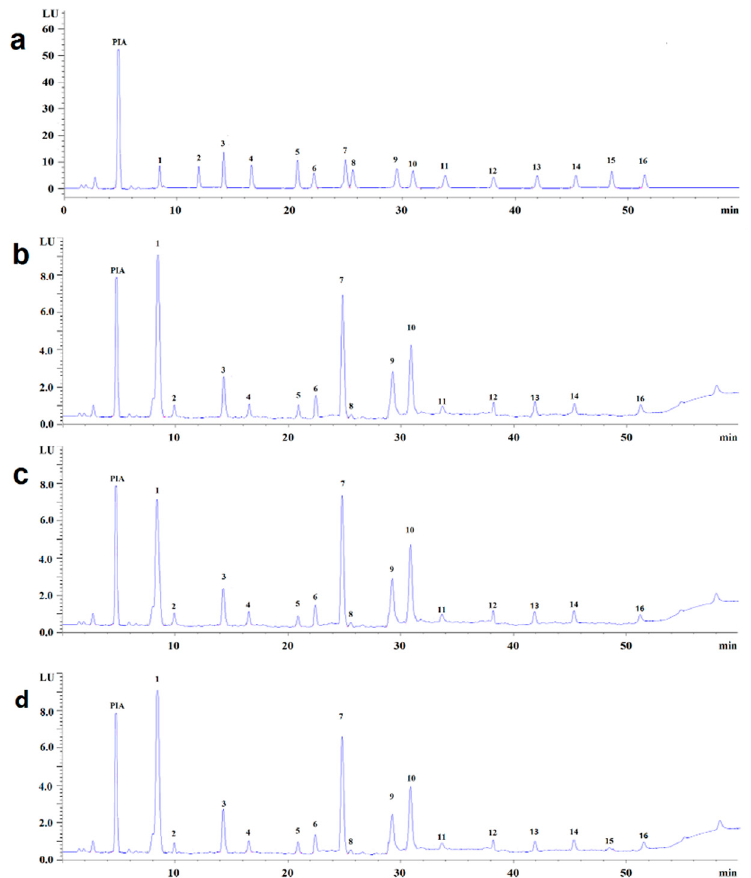
Figure 2. The representative chromatograms for standards ( a ), the typical chromatograms for fatty acid extracts in Potentilla anserina L from Gannan Tibetan Autonomous Prefecture by SFE ( b ), the typical chromatograms for fatty acid extracts in Potentilla anserina L from Gannan Tibetan Autonomous Prefecture by UAE ( c ), and the typical chromatograms for fatty acid extracts in Potentilla anserina L. from Gannan Tibetan Autonomous Prefecture by MAE ( d ). Peak labels are 1 for octanoic acid, 2 for capric acid, 3 for undecanoic acid, 4 for lauric acid, 5 for myristic acid, 6 for α -linolenic acid, 7 for linolic acid, 8 for pentadecanoic acid, 9 for palmitic acid, 10 for oleic acid, 11 for heptadecanoic acid, 12 for stearic acid, 13 for n -nonadecylic acid, 14 for arachidic acid, 15 for n -heneicosanoic acid, and 16 for behenic acid. PIA: 2-(4-amino)-phenyl-1-hydrogen-phenanthrene [9,10-d] imidazole.